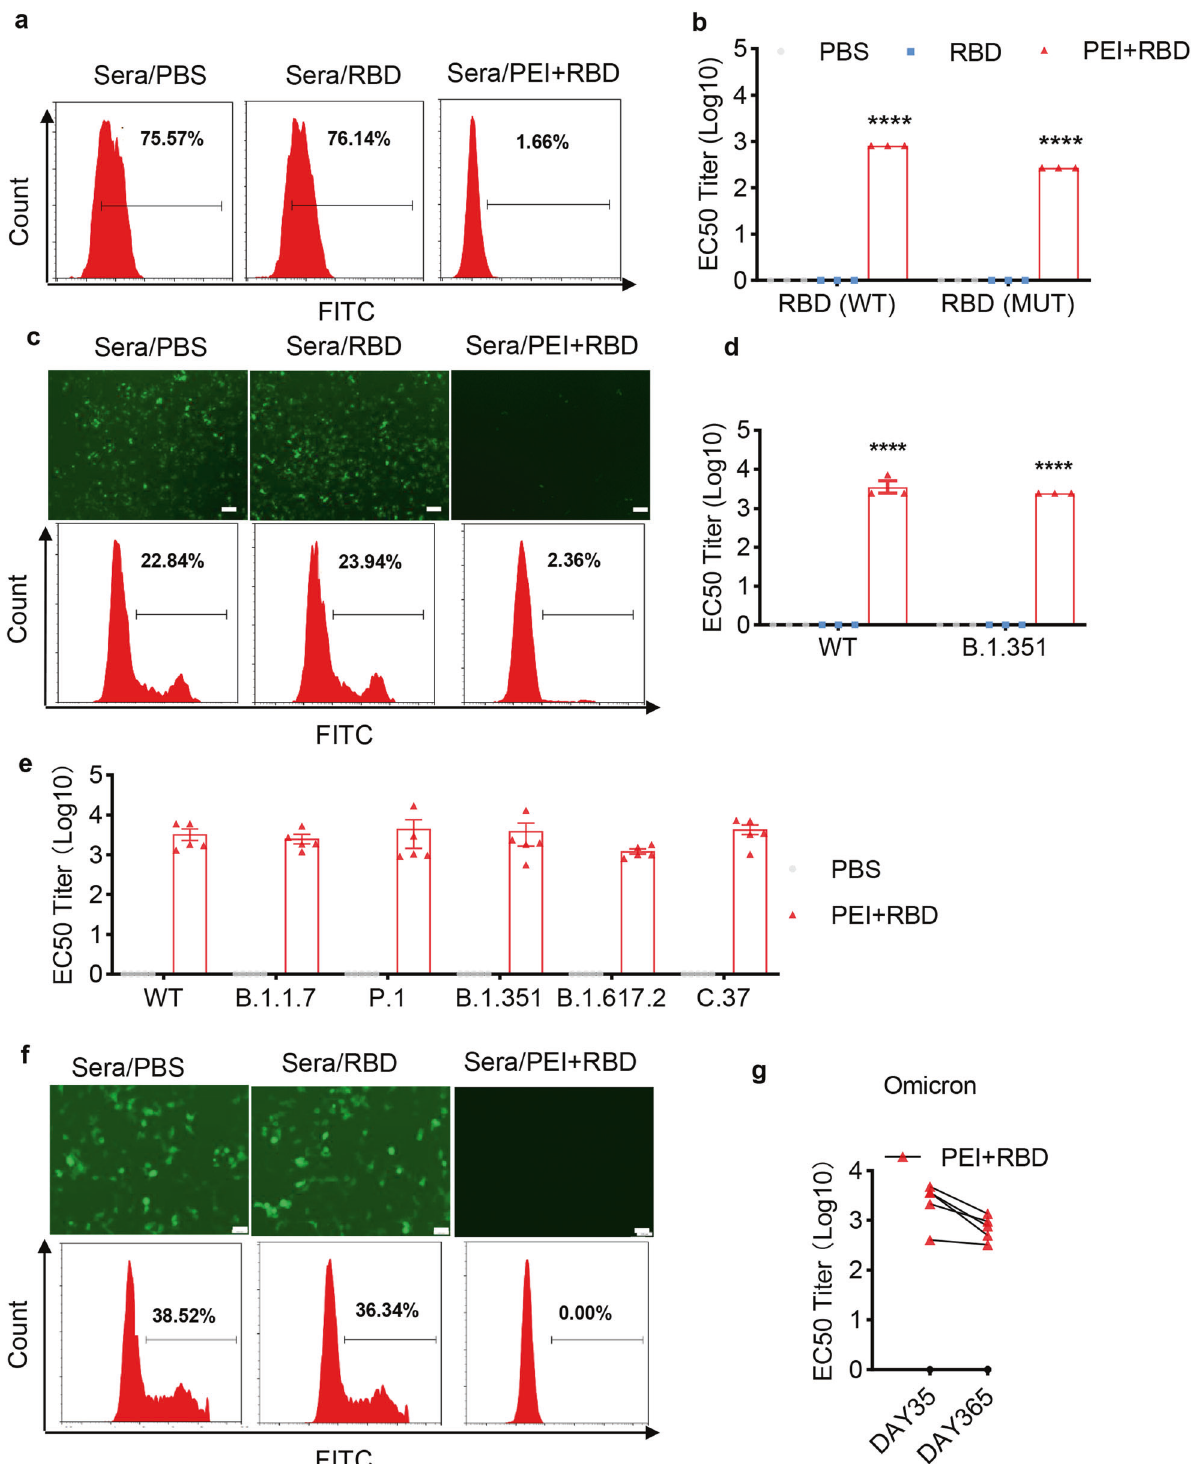
of the immune sera by using enhanced green fl uorescent protein (EGFP)-expressing pseudoviruses to infect 293T cells that stably express ACE2 (293T/ACE2). We observed that immune sera from PEI + RBD group signi fi cantly protected 293T/ACE2 cells from WT pseudovirus infection, as characterized by decreased number of EGFP-positive cells using fl uorescence microscopy and fl ow cytometry (FCM) (Fig. 2c, d). In addition, the immune sera